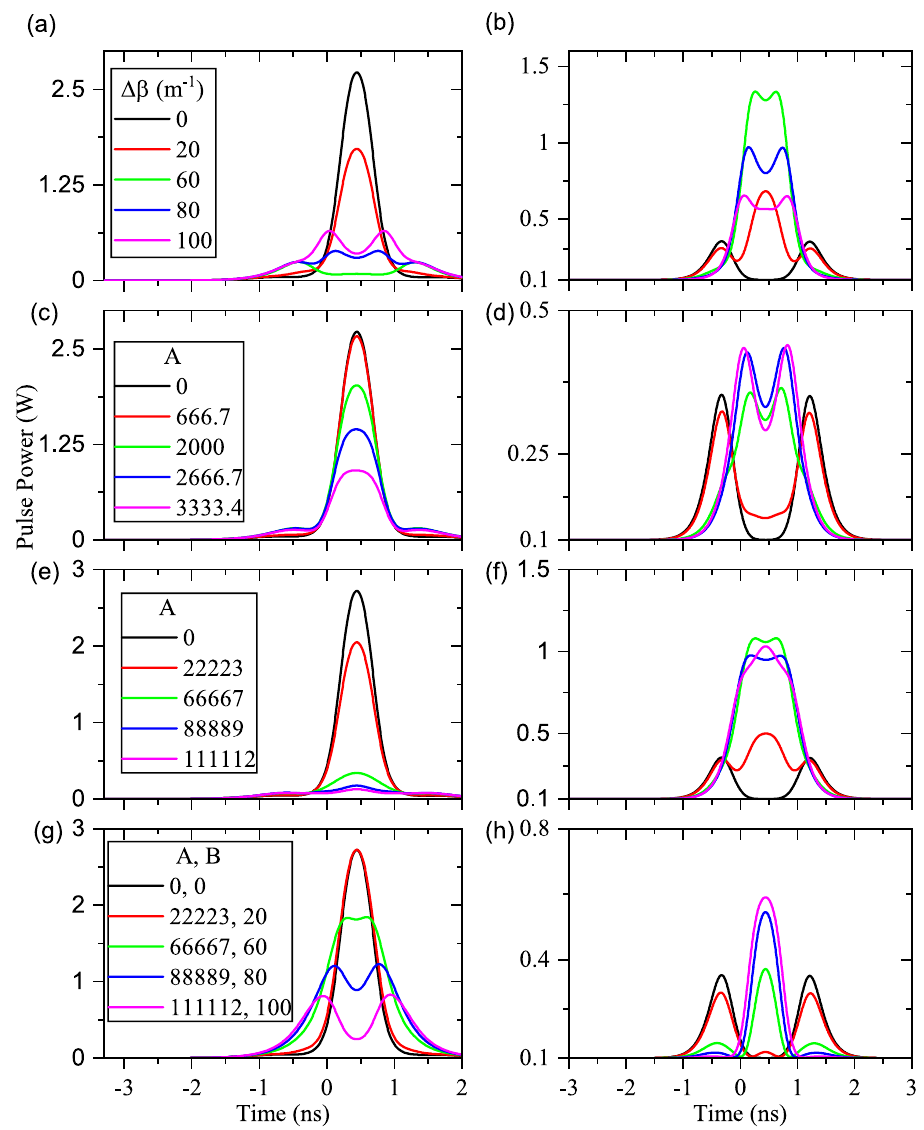
1 ). ( c ) and ( d ) 2 ). ( g ) and ( h ) represent the output